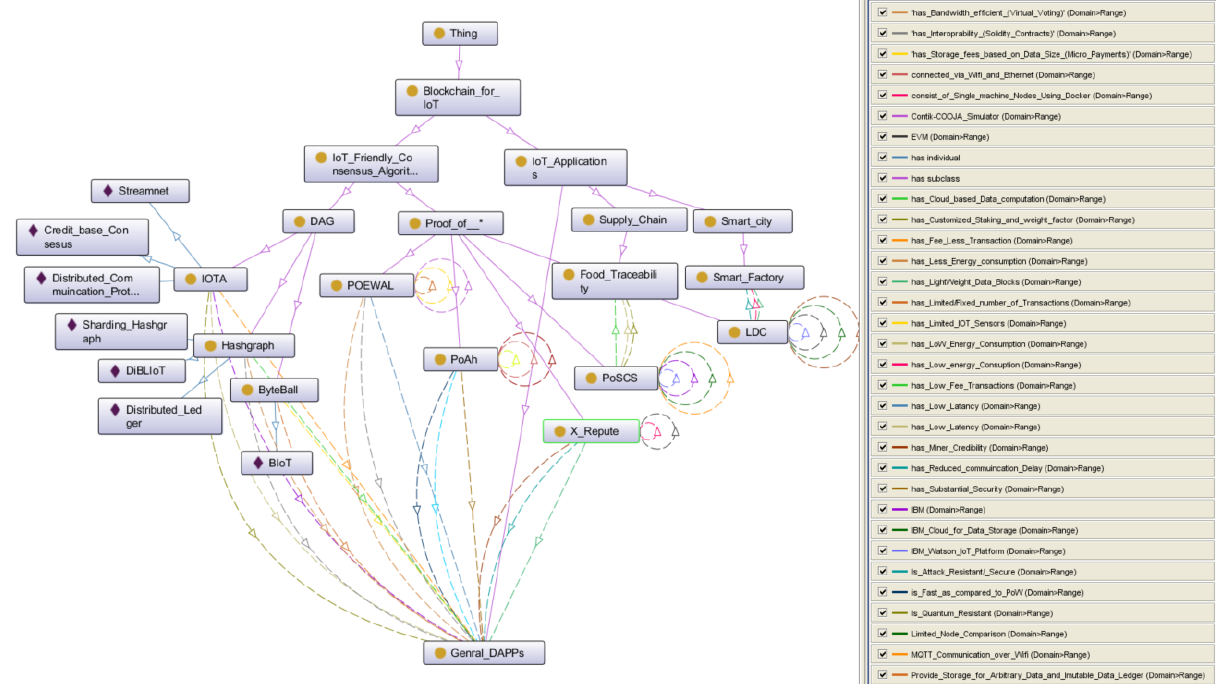
Figure 10. Consensus ontology for